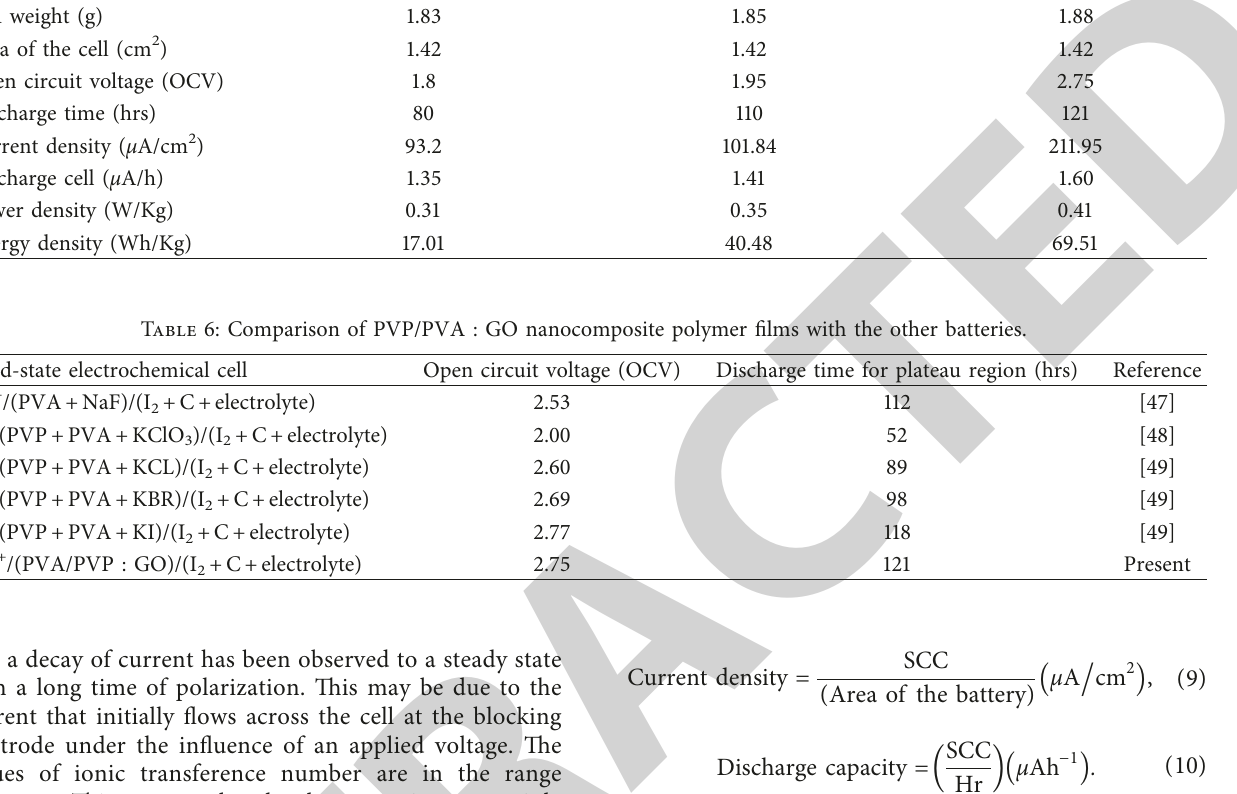
Table 5: Cell parameters of PVP/PVA : GO nanocomposite polymer films. Cell